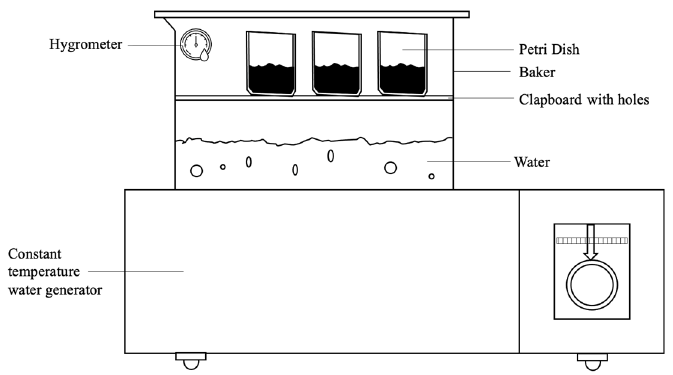
Figure 3. The experimental device of SWGR.